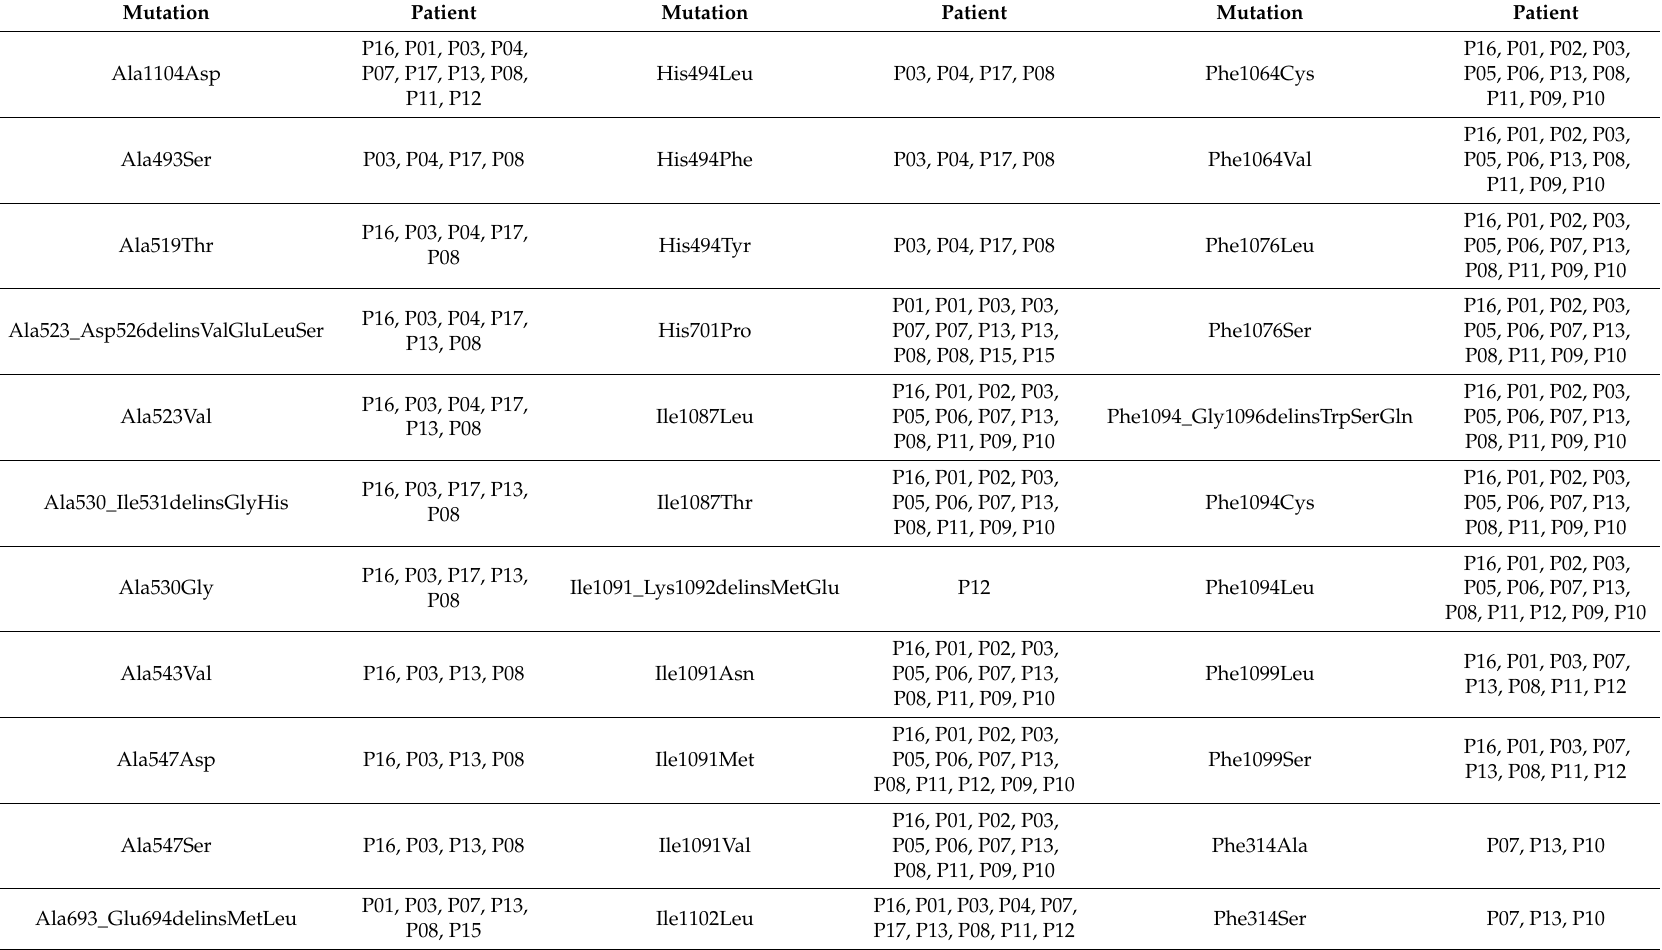
Table 3. Low frequent missense and del / ins mutations in ABCC1